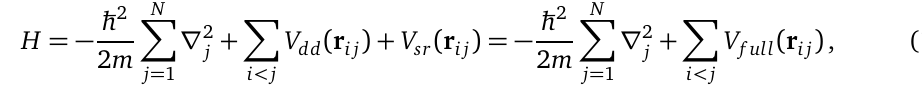
Figure 6: (Top) ratio of the DMC energies to the extrapolated N → ∞ value for x = 100 and α = 0. The solid line corresponds to a fit of the form f ( N ) = E from where the extrapolated value is obtained. (Bottom) Pair distribution function at x = 100 and α = 0 for N = 100 and N = 300 particles at the same